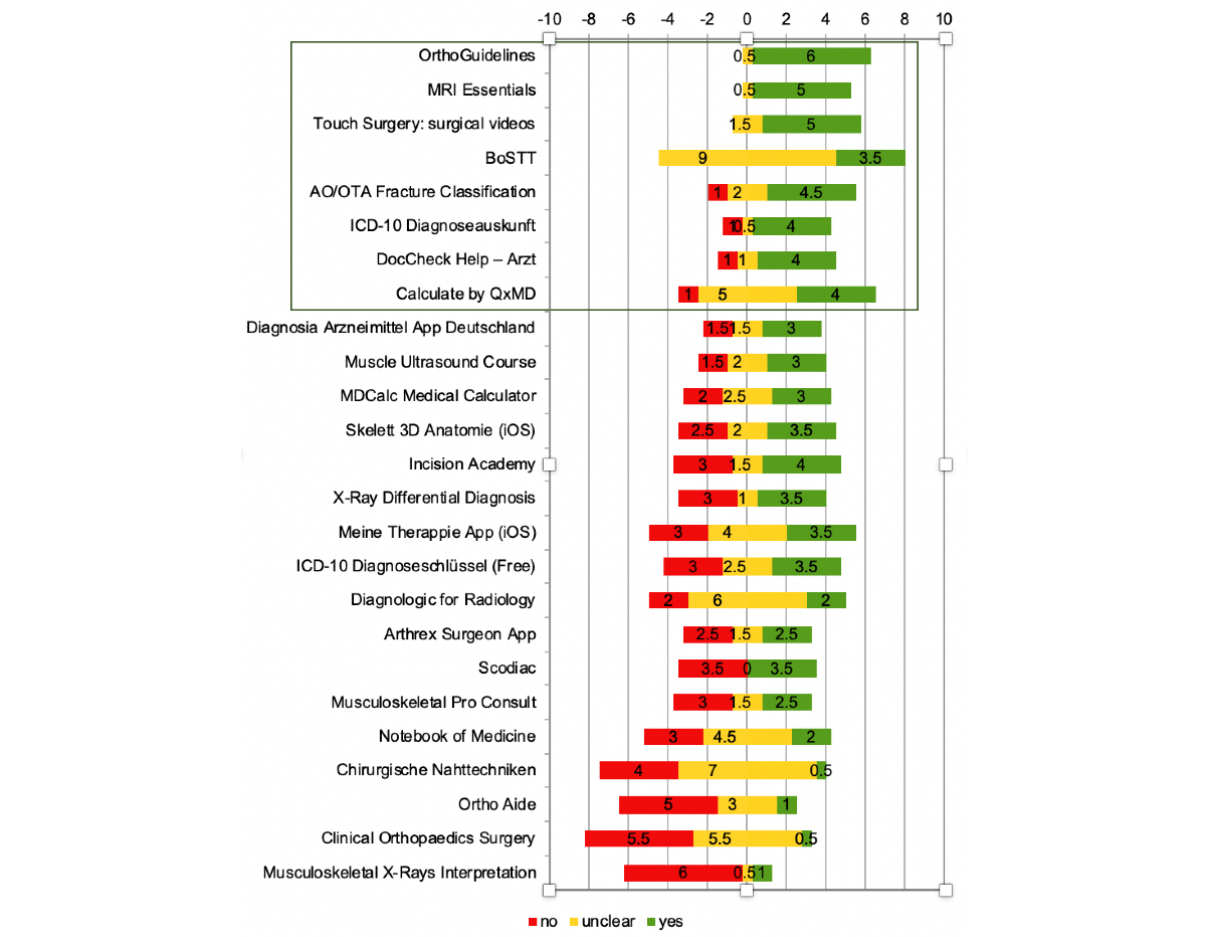
Figure 2. Mean ratings for trusted apps using the app synopsis—checklist for users. Every single app was ranked by two raters. Apps were primarily ranked in a “trustworthiness scale” (yes=+, unclear=±, and no=−) and secondarily by the following criteria: (1) ascending red (missing), (2) descending green (existing), and (3) ascending orange (unclear) trustworthiness marker. The lower red, higher green, and lower orange markers’quantity, the higher the app’s trustworthiness. AO/OTA: Arbeitsgemeinschaft für Osteosynthesefragen/Orthopedic Trauma Association; BoSTT: bone and soft tissue